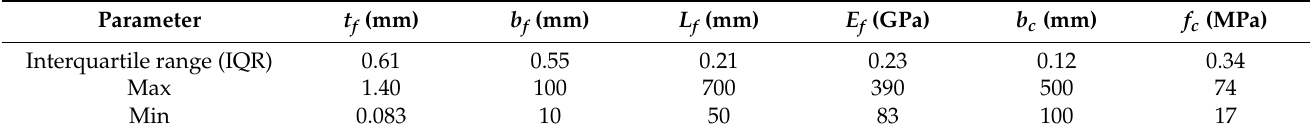
Table 2. Interquartile ranges of the input